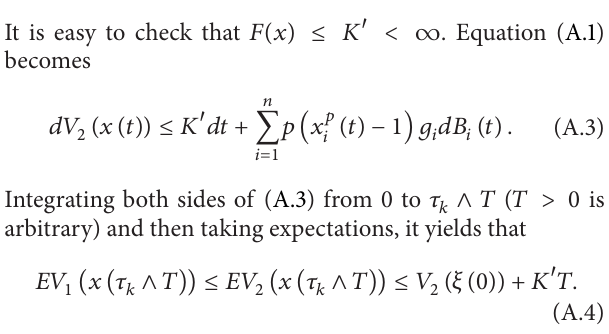
It is easy to check that 𝐹(𝑥) ≤ 𝐾 󸀠 < ∞ . Equation